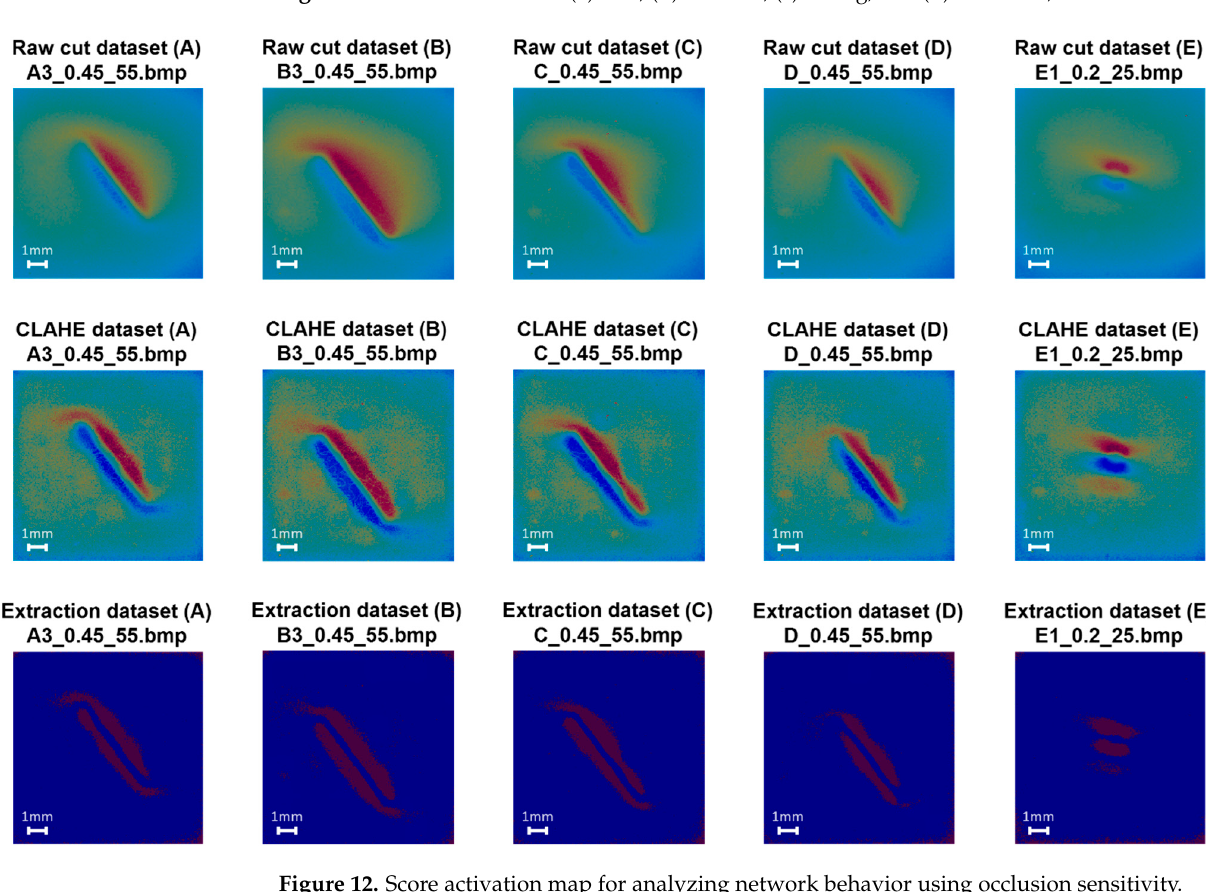
Figure 11. Confusion matrix: ( a ) best, ( b ) weakest, ( c ) voting, and ( d ) ensemble, of extraction dataset.